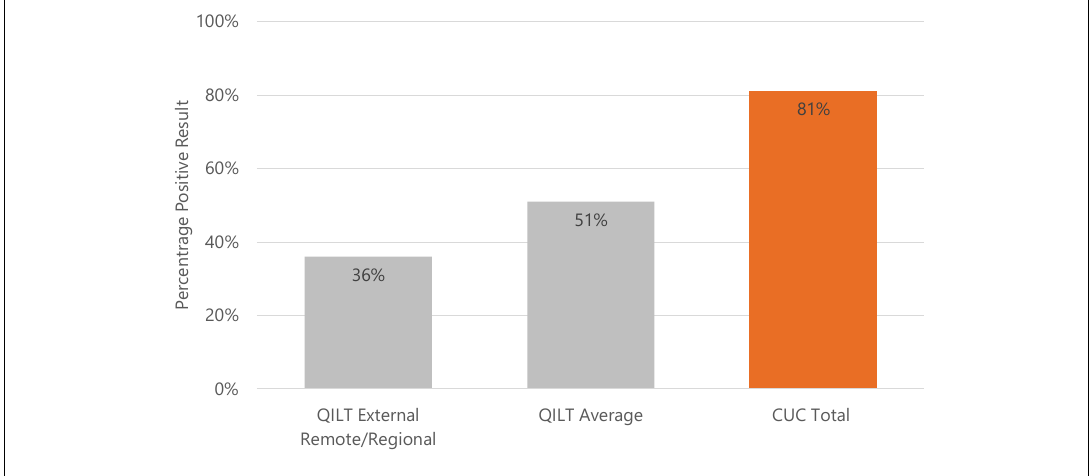
Figure 5. Sense of belonging, CUC survey results compared to QILT (QILT